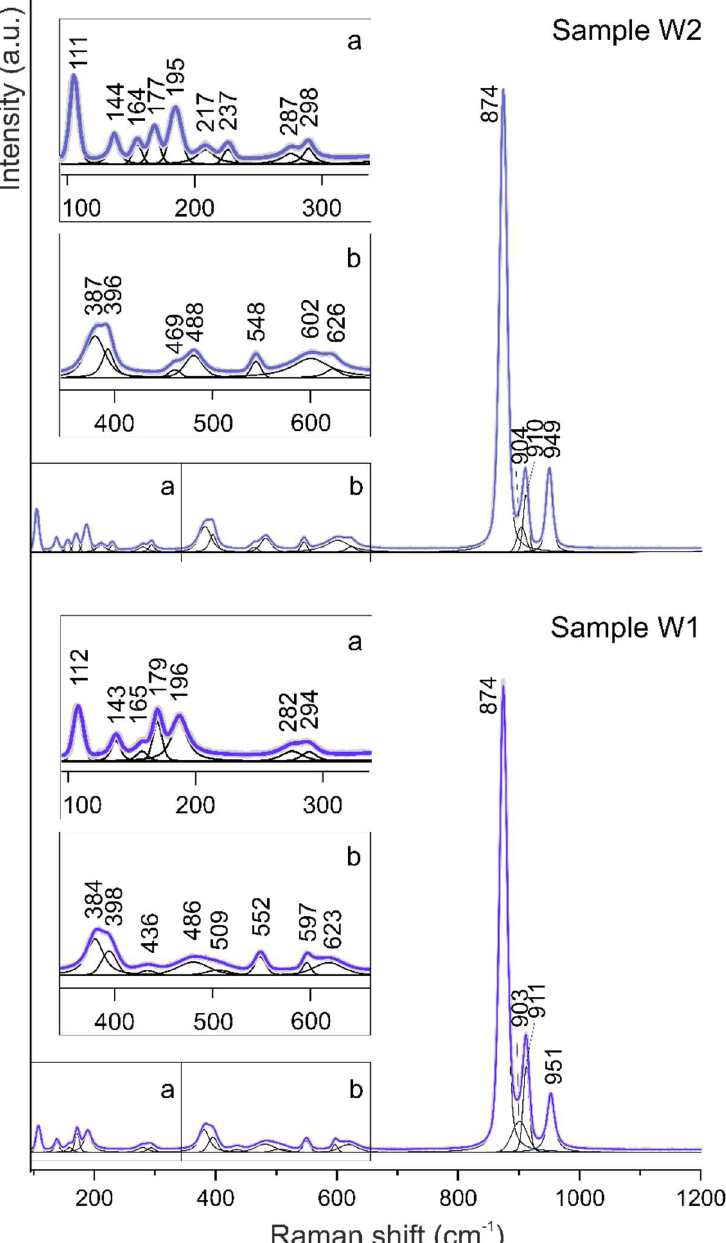
Figure 5. Raman spectra of willemite samples.